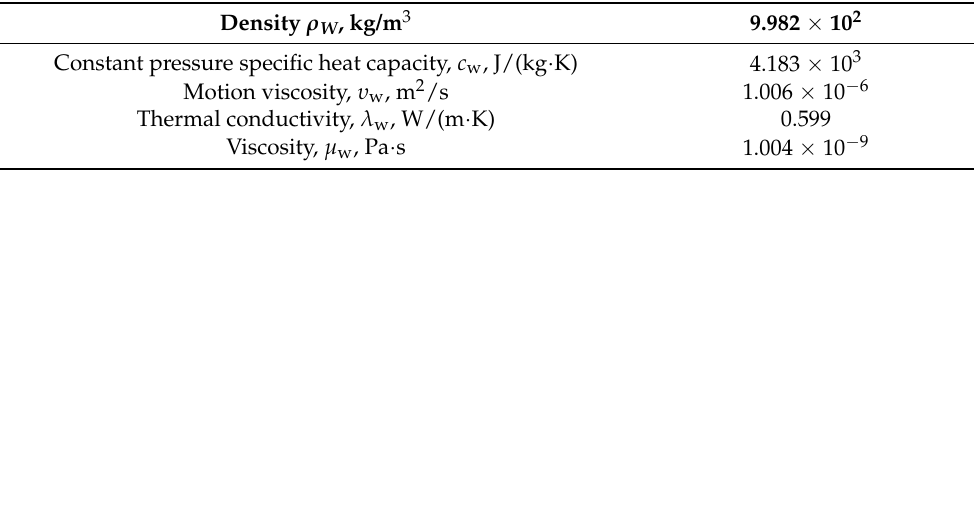
Table 1. Physical parameters of cooling water at 20 ◦ C [19] (p.